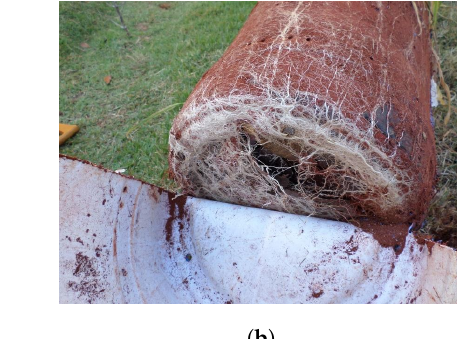
root mass. root mass. × × root ×